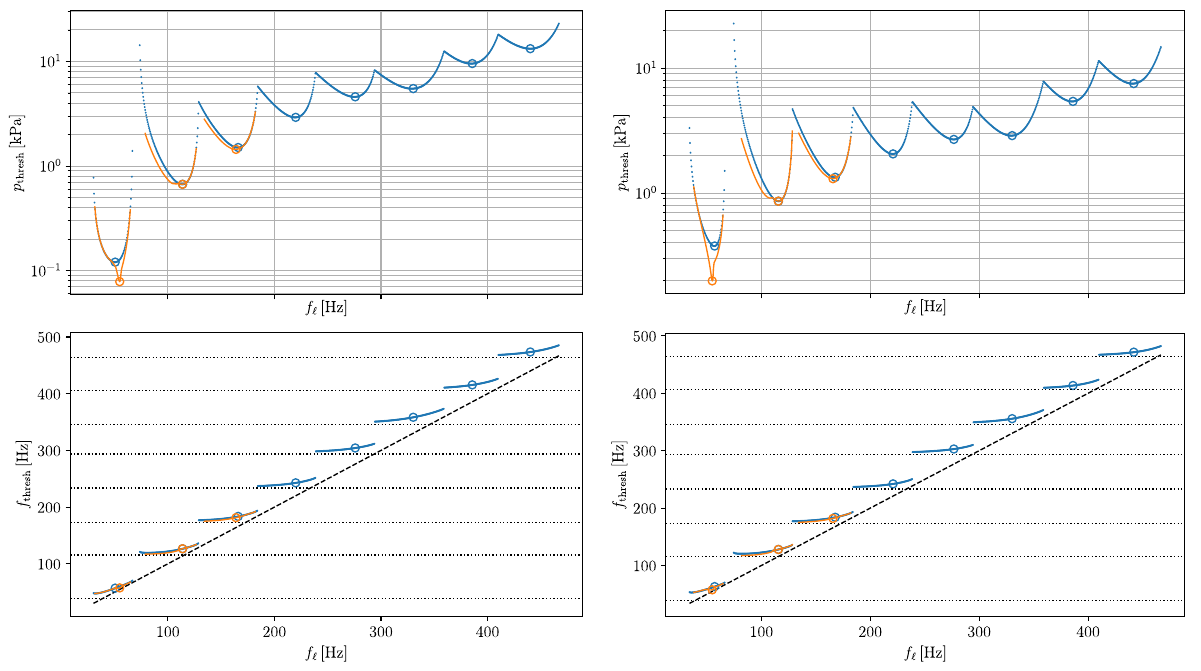
Figure 7. Top and bottom plots represent respectively the threshold pressures and threshold frequencies given by the linear stability analysis (blue) and the continuation method (orange) versus the lips ’ frequency. Left: case H = h 0 ; right: case H / 1 = f l . The circles identify the value of f l corresponding to a local minimum of blowing pressure. Horizontal dotted lines on the bottom plots locate the values of the acoustical resonances of the resonator; the black dashed line on the bottom plots represents f thresh ¼ f l .